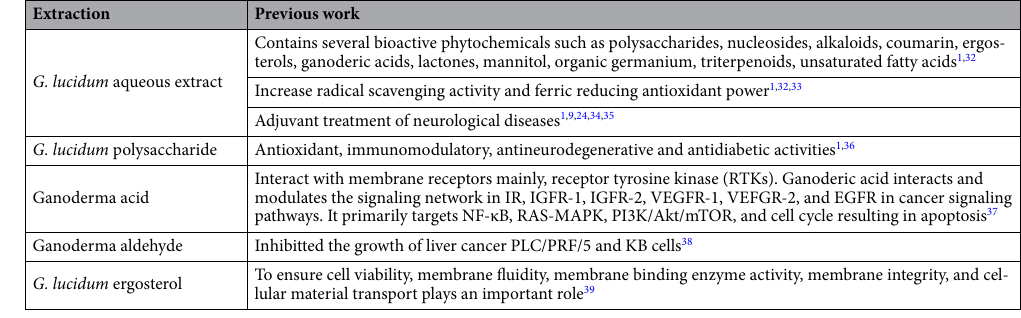
Table 1. Anti-aging researches of G. lucidum aqueous extract and main active monomers.